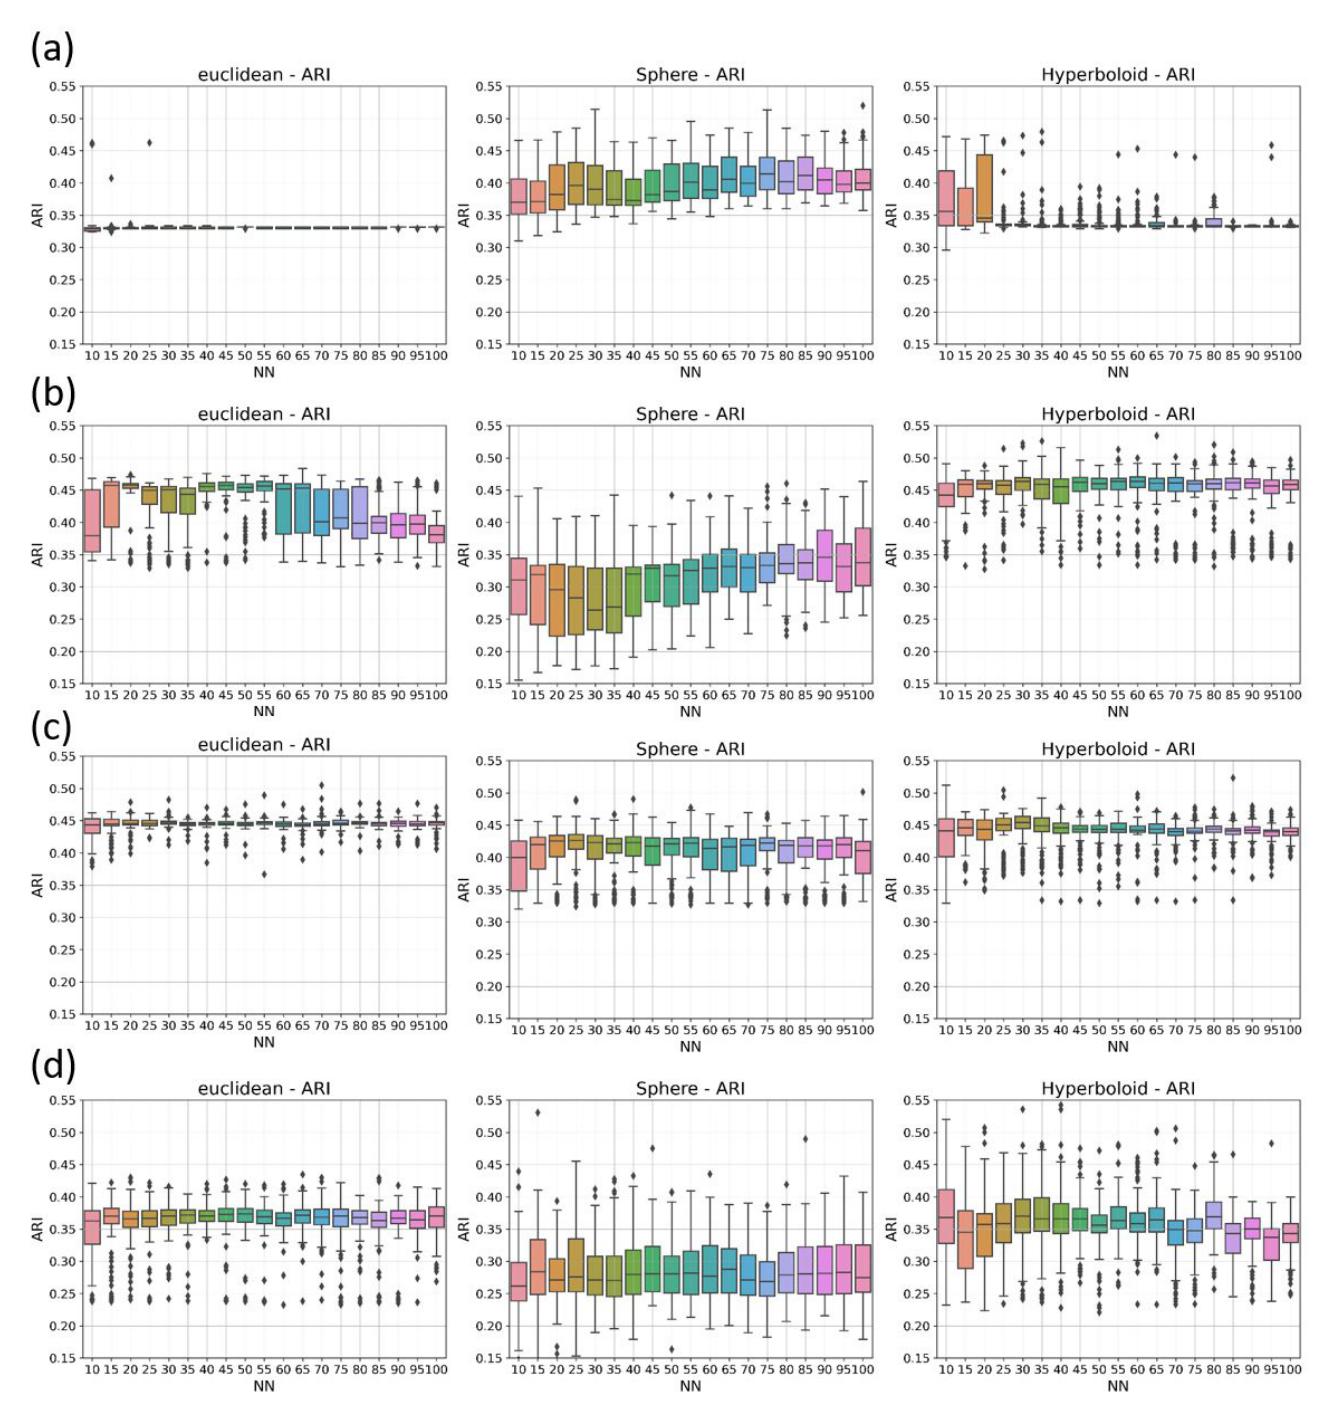
Figure 4. Variability of clustering performances. Quantitative results of HDBSCAN ( a ), DBSCAN ( b ), OPTICS ( c ), and agglomerative clustering ( d ) applied to T = 100 UMAP embeddings, in terms of ARI for each NN. From left to right, panels correspond, respectively, to Euclidean, spherical, and hyperbolic space. Each boxplot represents the distribution of the ARI values, along the T iterations for each specific